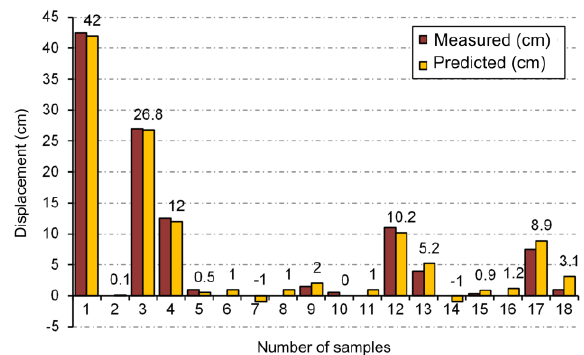
Figure 2. Comparison of predicted and measured deformation for training first 18 data samples